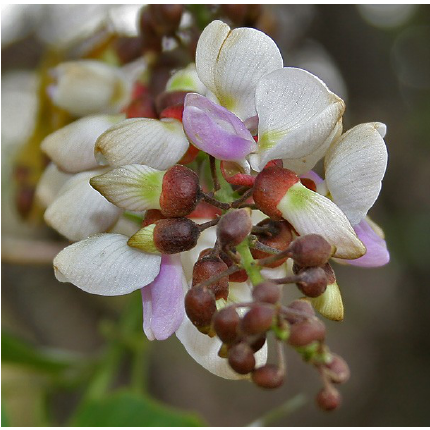
Figure 7. Pongamia pinnata